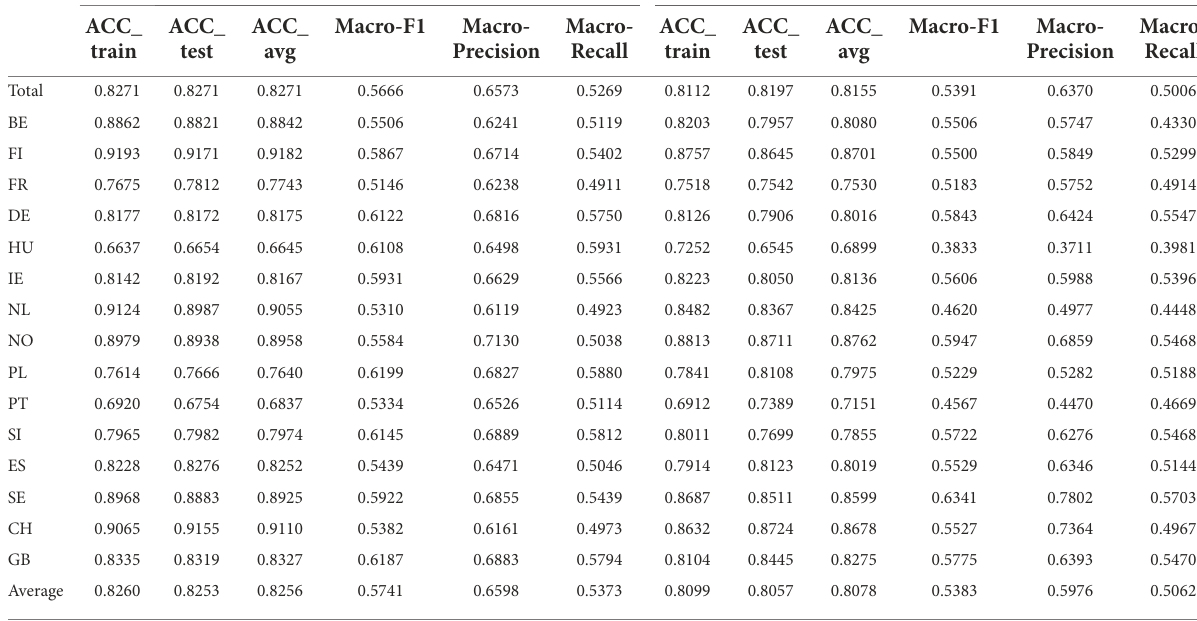
TABLE 4 The performance metrics of OLR